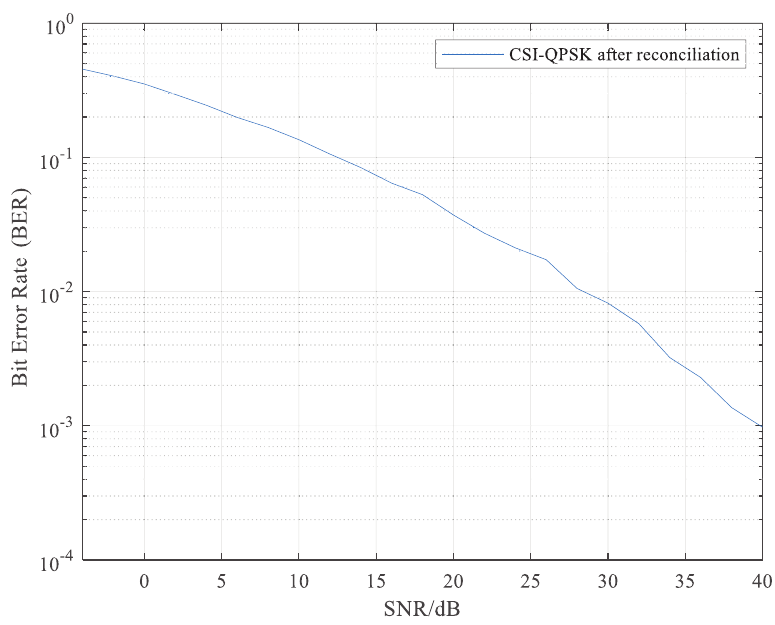
Figure 11. BER after information